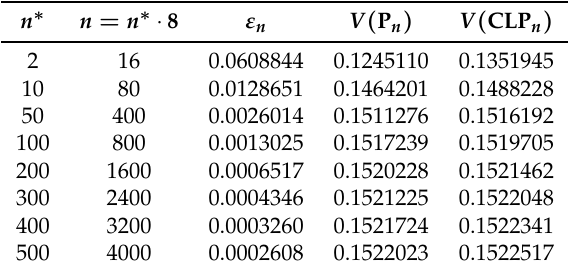
Table 1. Numerical